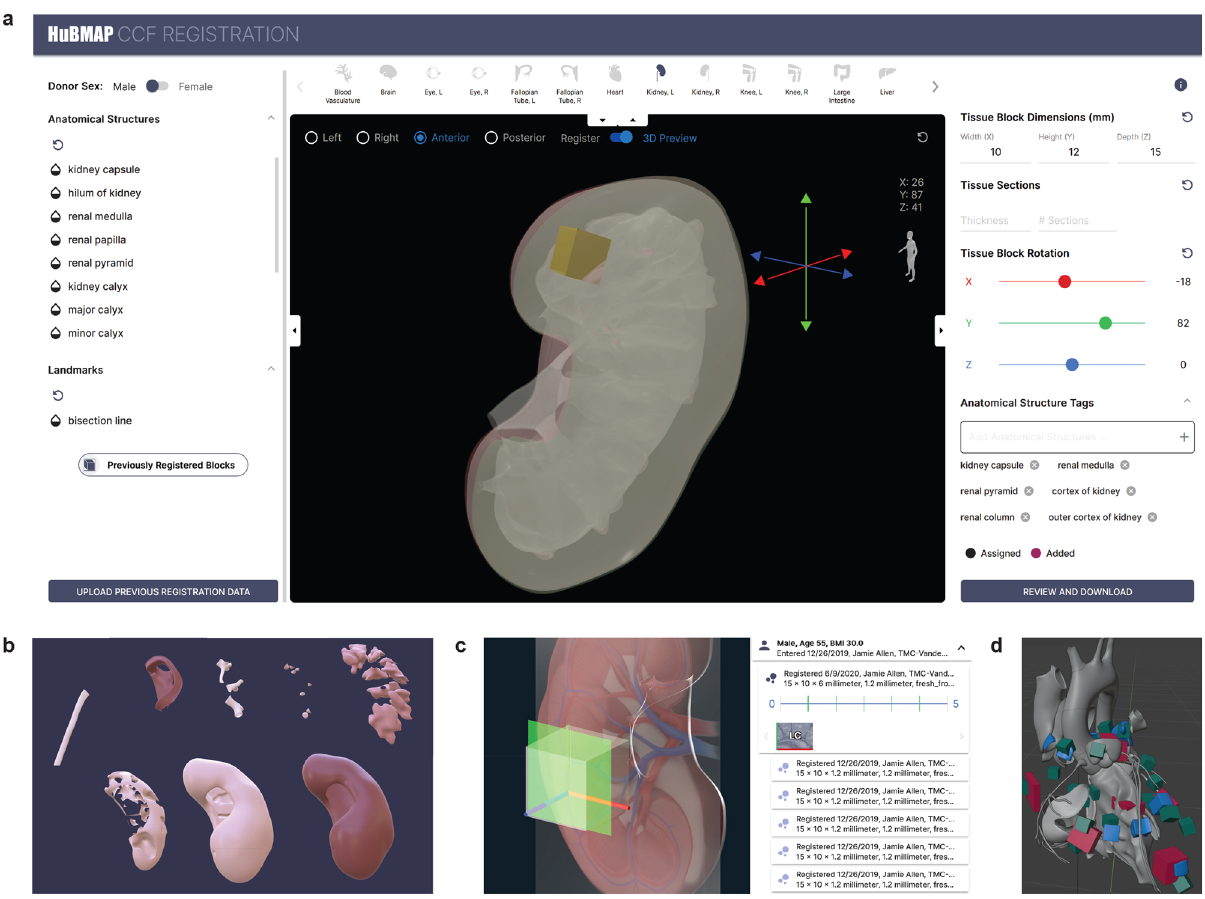
Fig. 1 Tissue Registration User Interface (RUI). a Tissue registration for kidney using the RUI. b Named anatomical structures that together make up the male right kidney reference object. c Relationship of cutting plane (in green) to x-y-z coordinate system (red, green, blue axes) of the 3D tissue block are shown on left. Details panel on the right-hand side of the EUI with information on what tissue sections exist for a tissue block (blue lines in strip plot) and green-red axes on the left and bottom side of each thumbnail. d Common tissue extraction sites used by three different consortia for the male heart (six sites for HCA in red, 10 sites for HuBMAP in blue, 25 sites for SPARC in